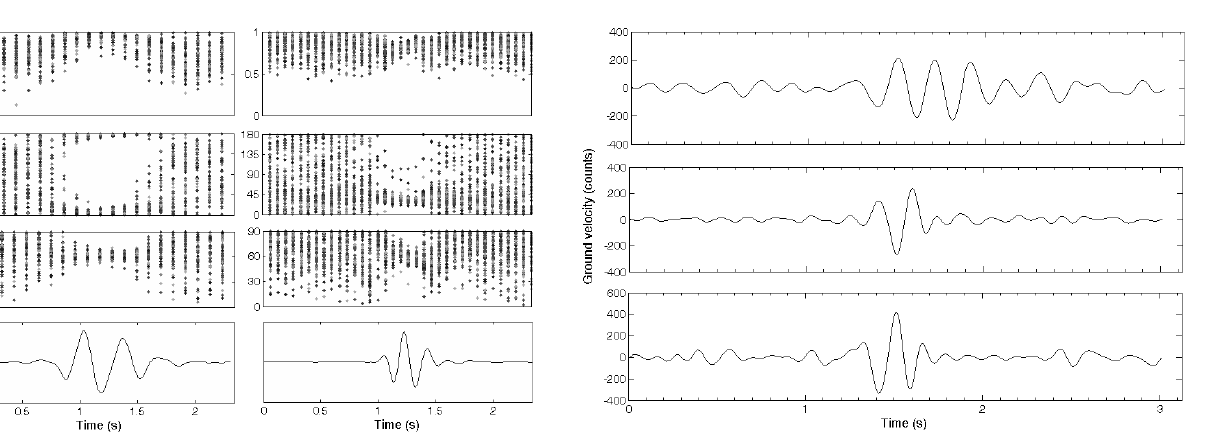
Fig. 4. Polarization analysis of the Class A (on the left columns) and Class B (in the right column) detected in Series I. From top to bottom: rectilinearity (RL), polarization azimuth, polarization dip and the shape of the typical event. Each dot in the plots in the first three rows represents results of the polarization analysis obtained by considering a sliding window centred at the respective abscissa for a single segment of the global time series. Time windows of 0.5s and 0.3s were considered respectively for the Class A and Class B, with an overlap of 75%.